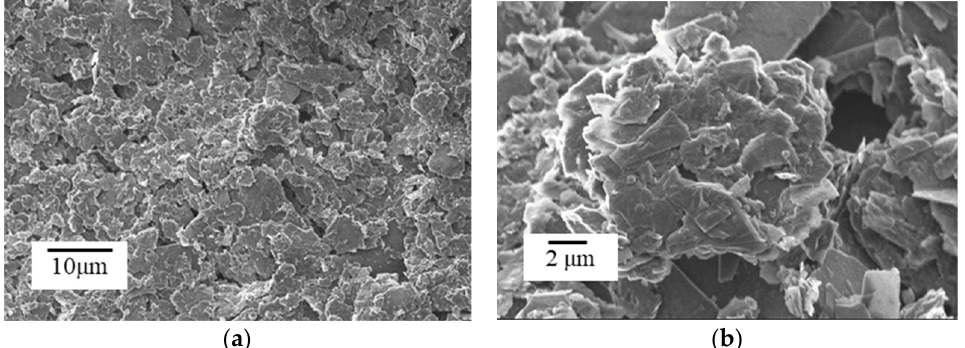
Figure 9. FESEM images of graphene films: ( a ) overview of graphene film at magnification of 10 m; ( b ) magnified at 2 m, flakes embedded in graphene film can be seen.